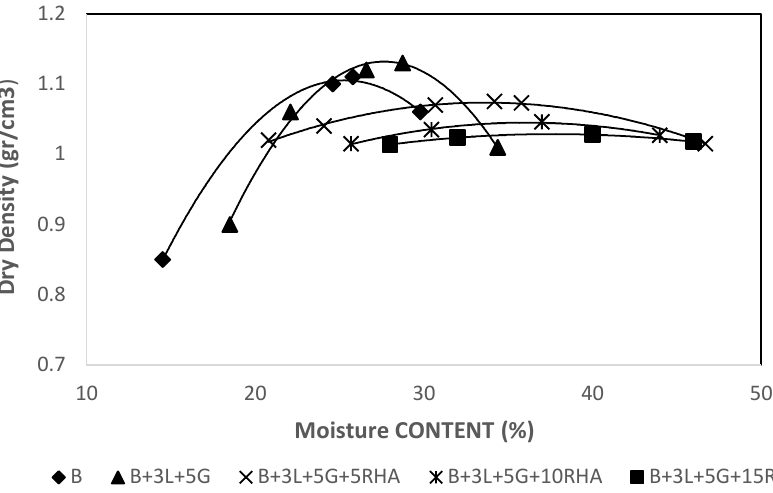
Figure 2. Effect of RHA on compaction curve of the soil stabilized with lime in the presence of